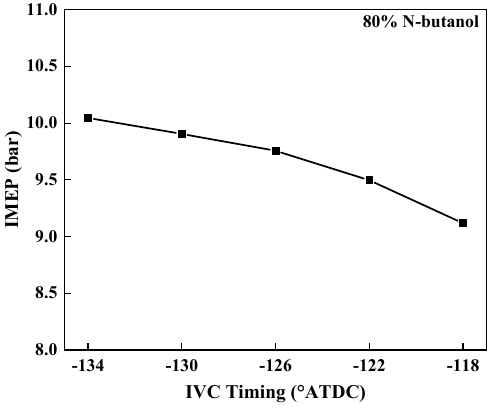
Figure 18. IMEP for various IVC timings.